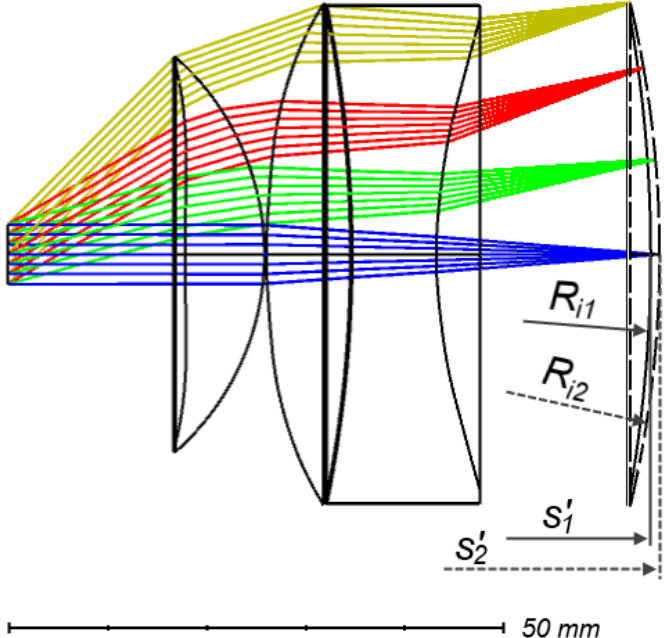
Figure 3. Overview of the optical design illustrating the variable field curvature